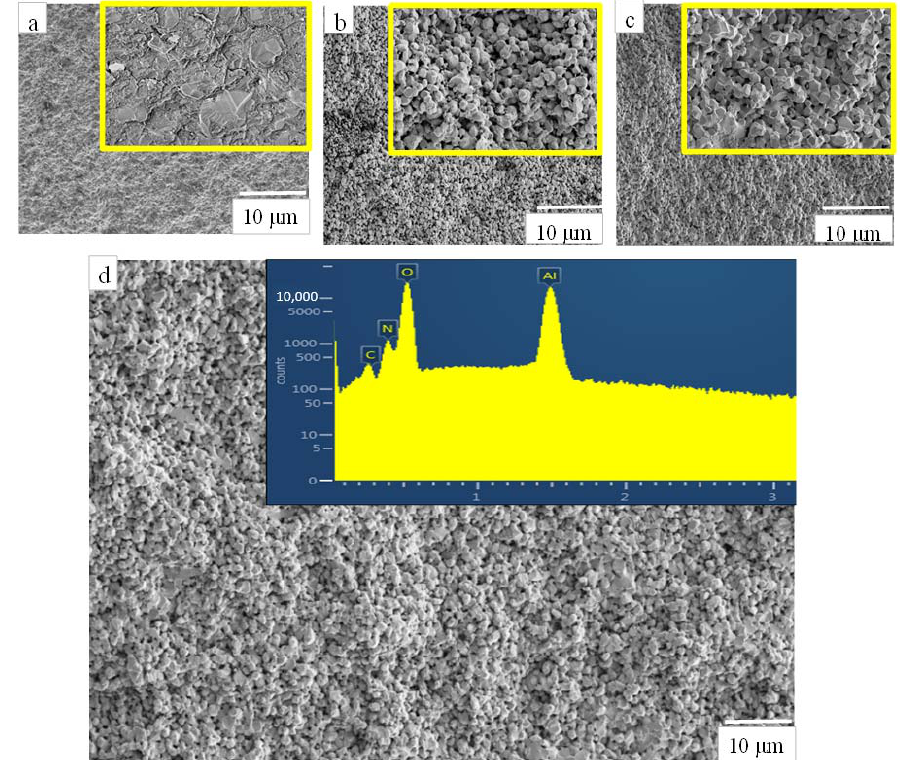
Figure 4. SEM micrographs of Hot Isostatic Pressing sintered AlN ‐ Al 2 O 3 samples: ( a – d ) are after 0, 3, 10, and 20 h of oxidation time along with EDS ‐ spectra of the 20 h sample was also shown in support of the above micrograph indicating the strong presence of Al, O, N peaks. High magnified images (2000×) of the respective images were also provided in the inset.